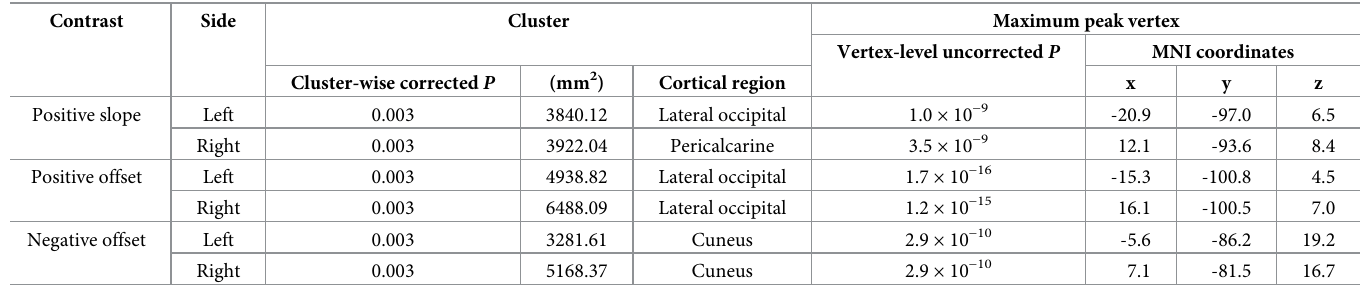
Vertex-level uncorrected P MNI coordinates